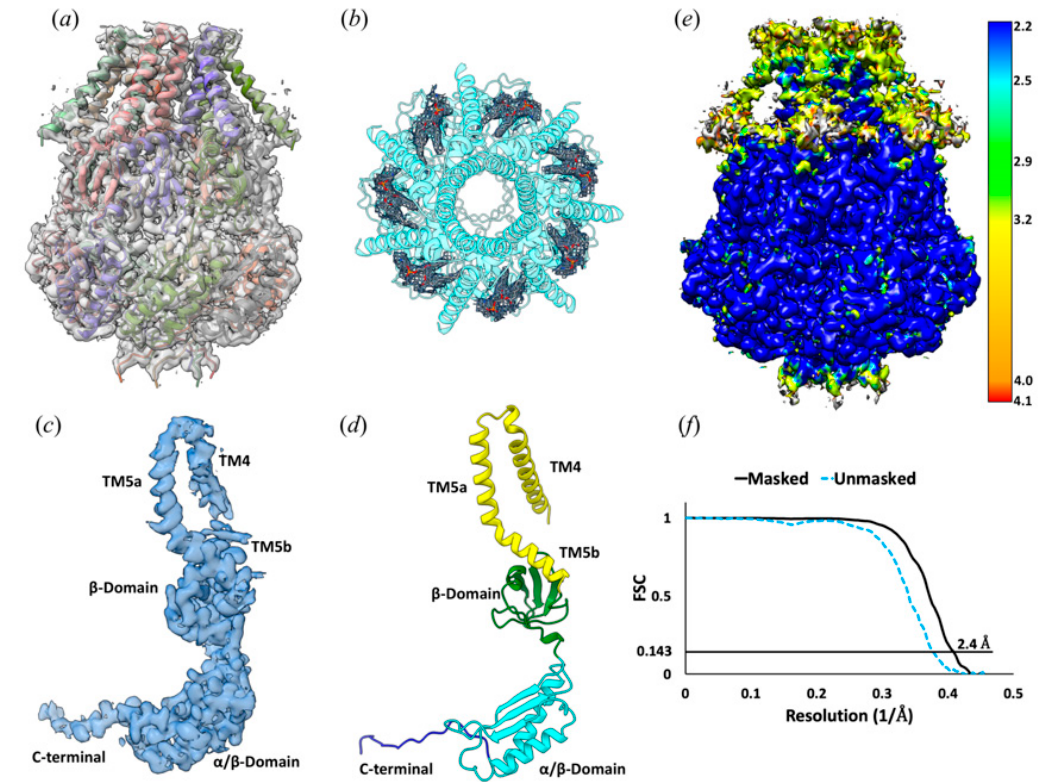
Figure 2. Cryo-EM structure of the YnaI channel. ( a ) the EM density at 2.4 Å resolution fitted with a YnaI heptamer, shown in cartoon representation. Each monomer is shown in a different color. ( b ) Seven PE molecules fitted into the density within the hydrophobic pockets between adjacent subunits of the YnaI heptamer. ( c ) The EM density at 2.4 Å resolution of one protomer. ( d ) Cartoon diagram showing the structural features of the YnaI monomer colored for each of the distinct domains. ( e ) The local resolution estimation of the YnaI map was calculated with ResMap. ( f ) FSC curve of the unmasked and masked map.